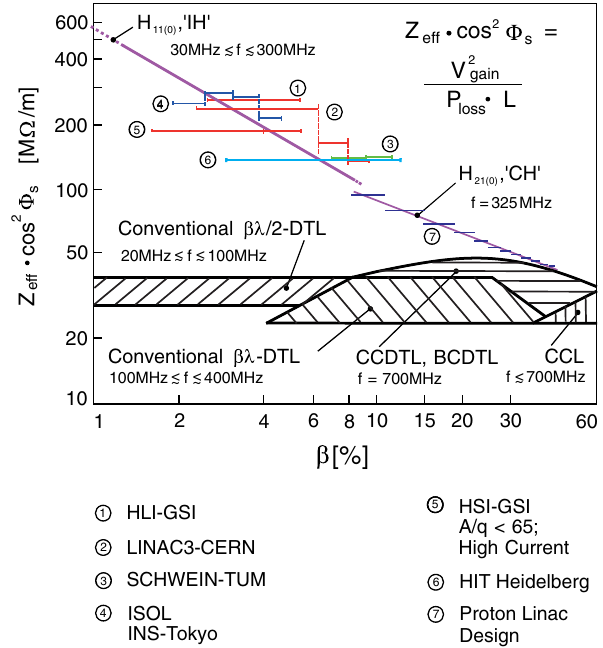
FIG. 3. Shunt impedance plot of DTL structures for low β and up to around 100 A MeV. The H-type structures (IH and CH cavities) are very efficient up to 100 A MeV beam energy. L denotes the cavity length. ϕ c;i denotes the synchronous phase of the bunch in gap no. i (compare Secs. II and III), while h ϕ c i is the effective value — averaged over all gaps of a